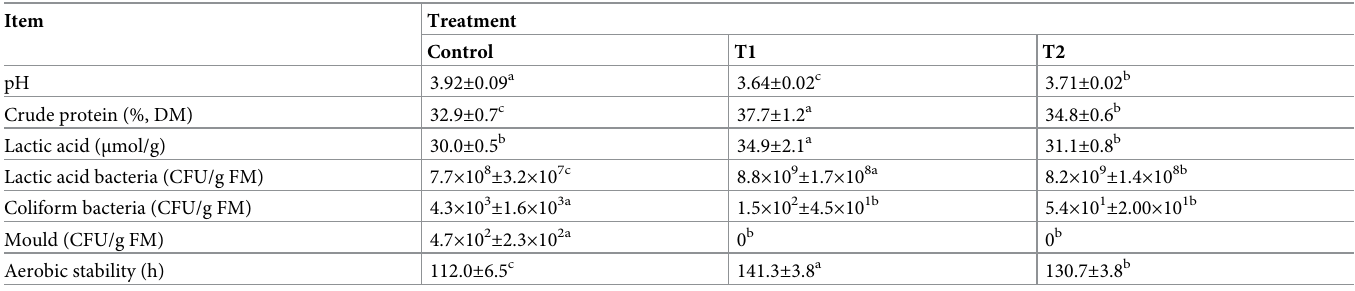
Table 2. Fermentation characteristics of food waste fermentation products.